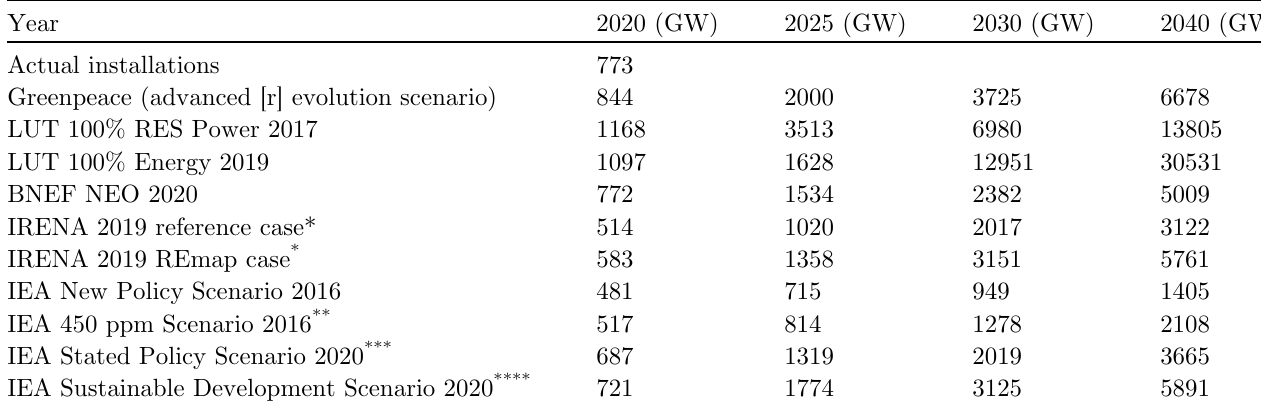
Table 1. World-wide scenarios of cumulative solar photovoltaic electrical capacities until